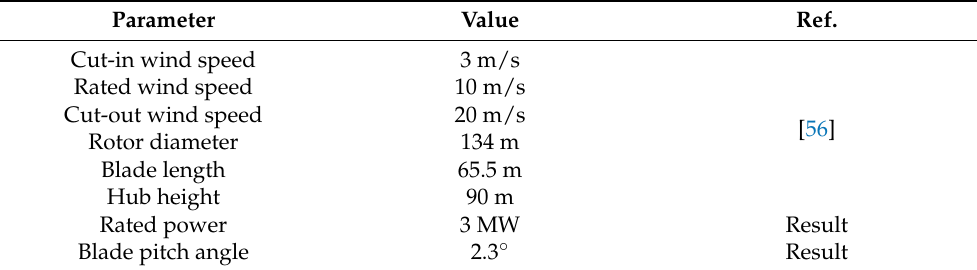
Table 4. Design parameters of the wind turbine. Parameter Value Ref.